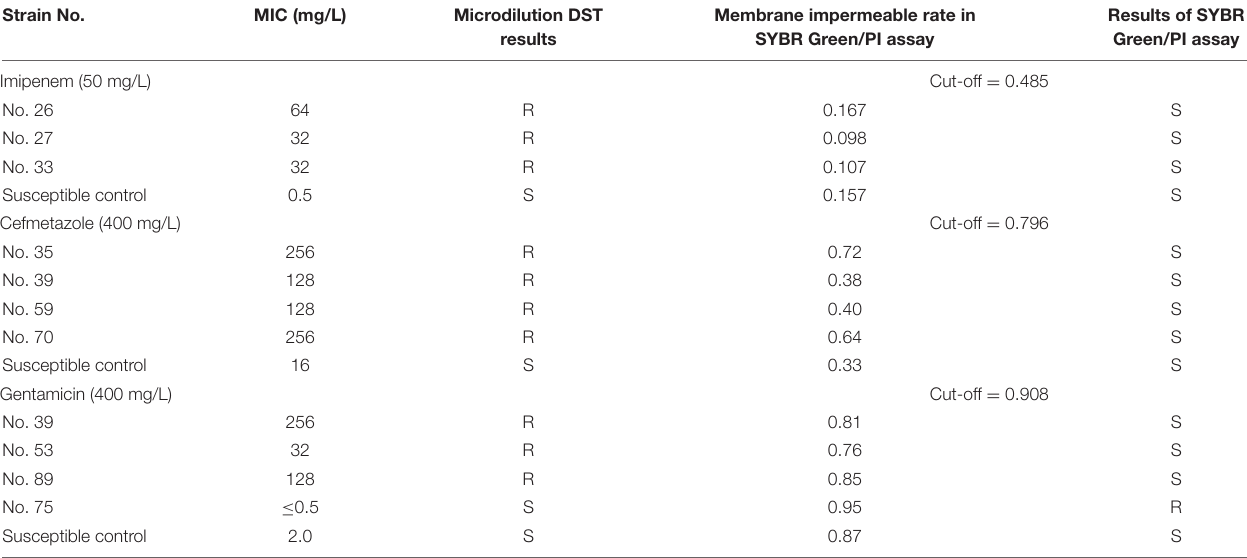
TABLE 2 | Detailed information of all discordant results between the microdilution MIC DST and the SYBR Green/PI DST method. Strain